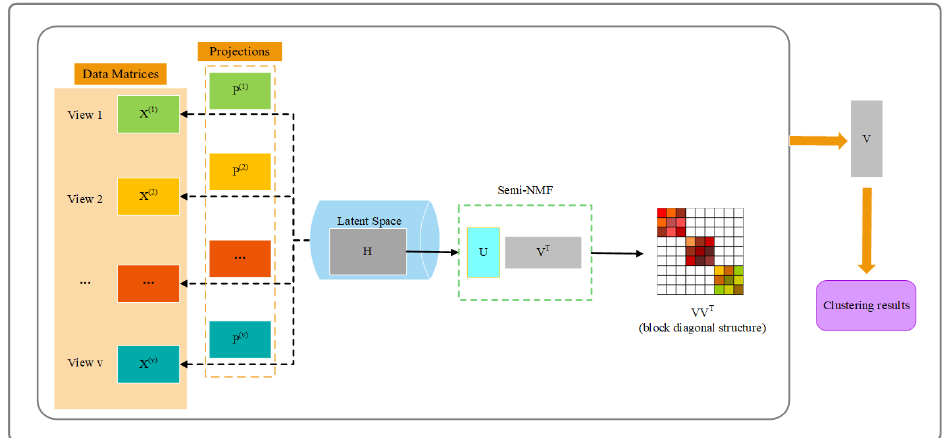
Figure 1. The general framework of our proposed approach. X ( i ) and P ( i ) represent the data matrix and projection matrix from the i -view, respectively. H denotes the latent representation of multi-view data. The basis matrix U in Semi-NMF is free while the encoding matrix V is constrainted to be nonnegative. We assume that VV T is a k -block diagonal matrix in our